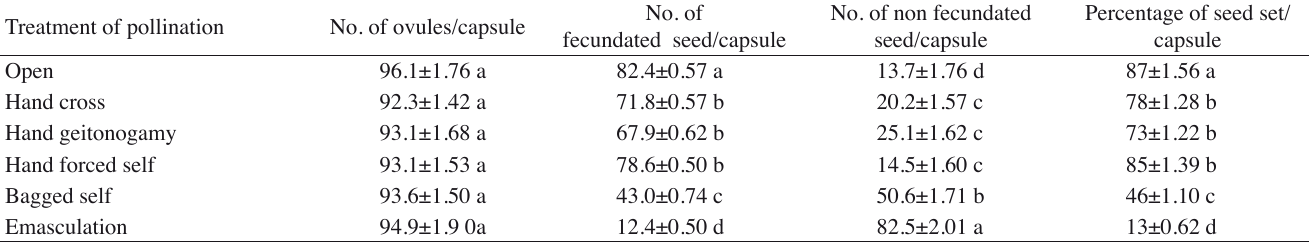
Table 5 - Behavior of honey bees and their bearings for Nigella sativa